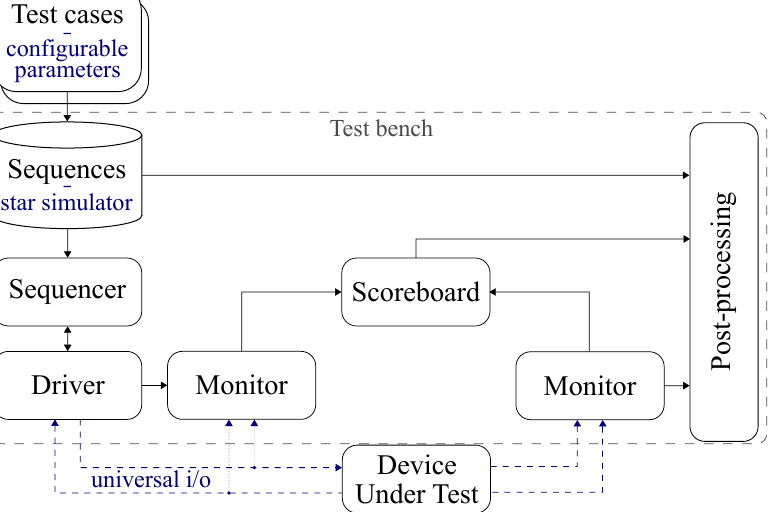
Figure 2. Structure of the verification platform. Following Universal Verification Methodology (UVM) nomenclature, the composing blocks are linked to their specialised functionalities for the particular case of verifying star